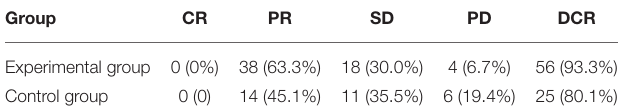
TABLE 2 | DCR ( n , %), ( P = 0.18). Group